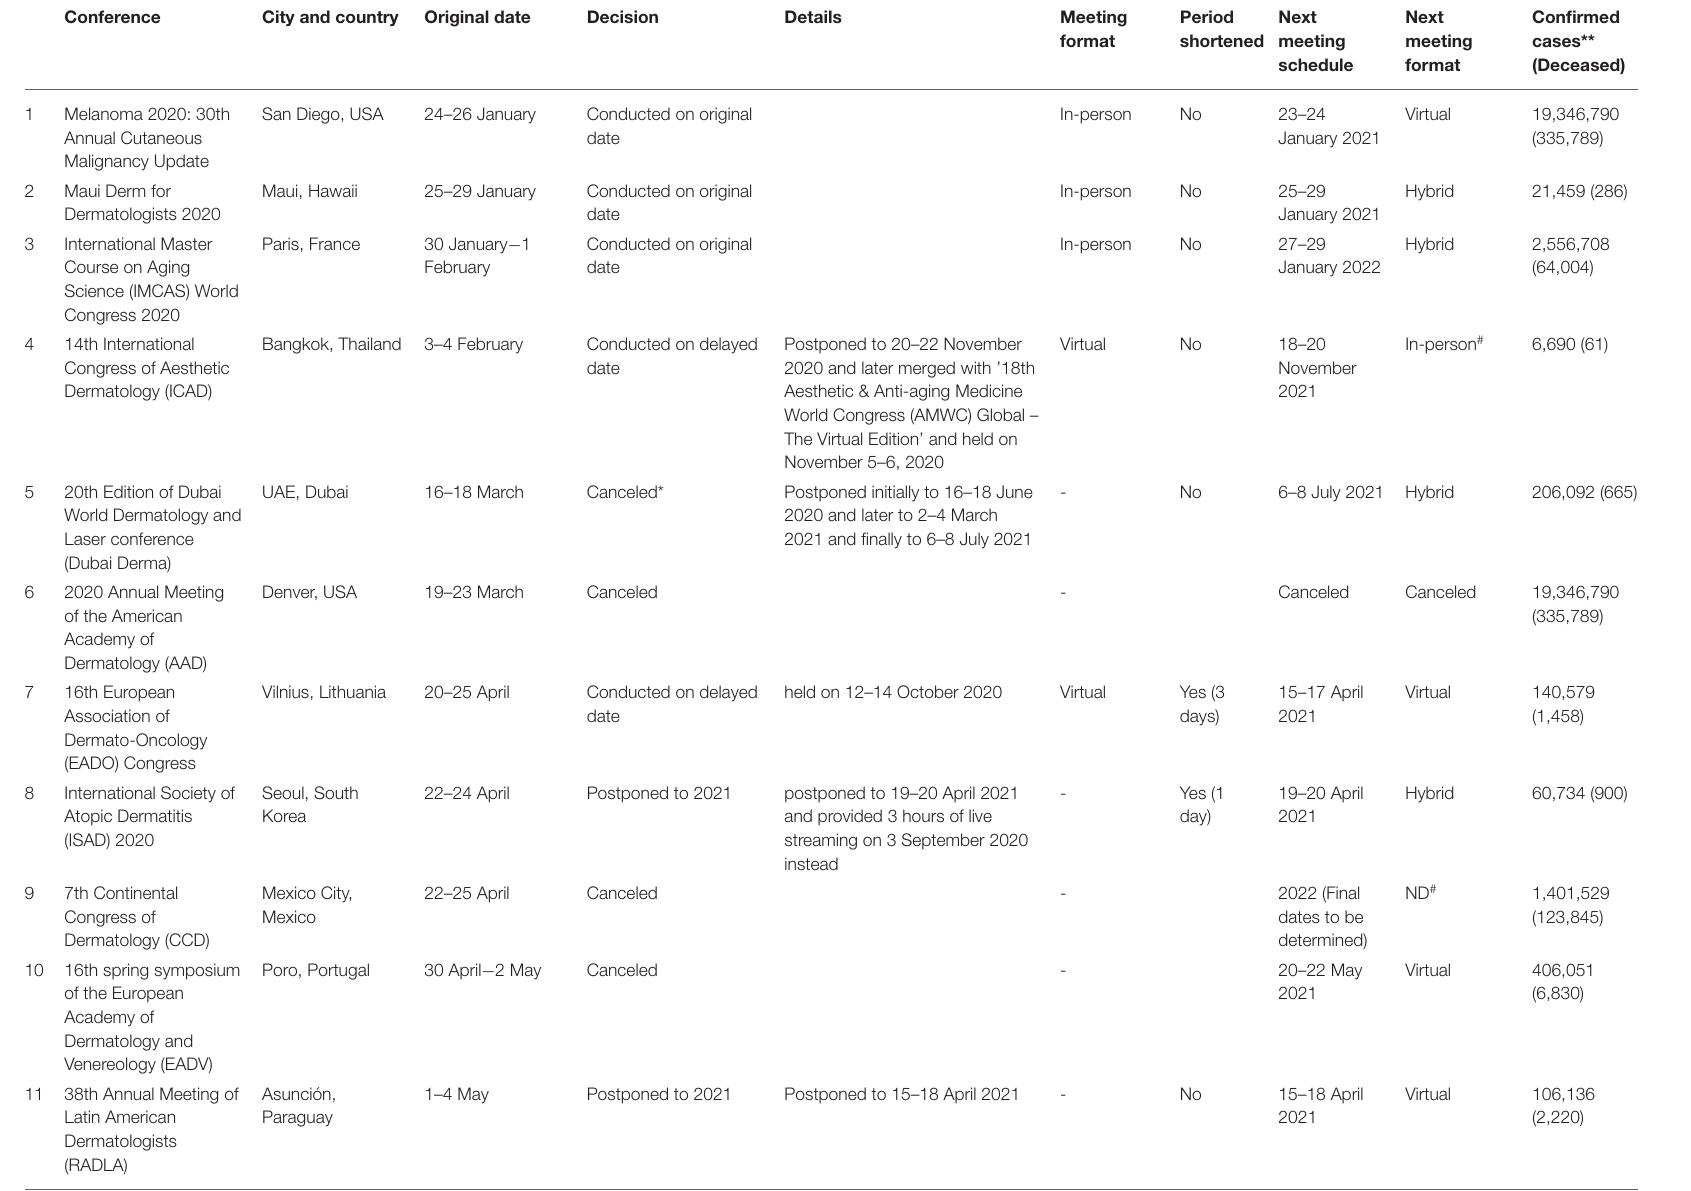
TABLE 1 | Summary of major dermatology conferences in